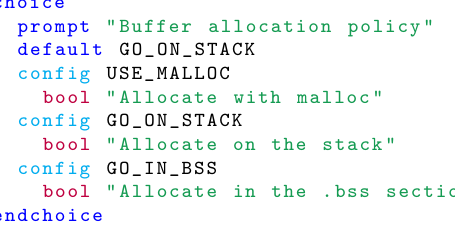
Figure 4. A Kconfig code